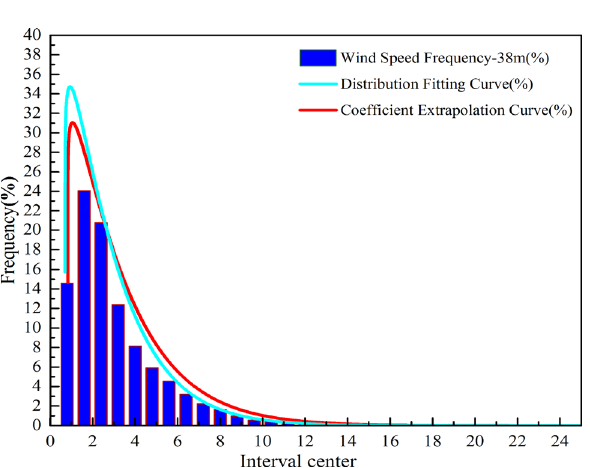
Figure 13. Probability distribution and extrapolation probability distribution curves of actual wind speed at 38